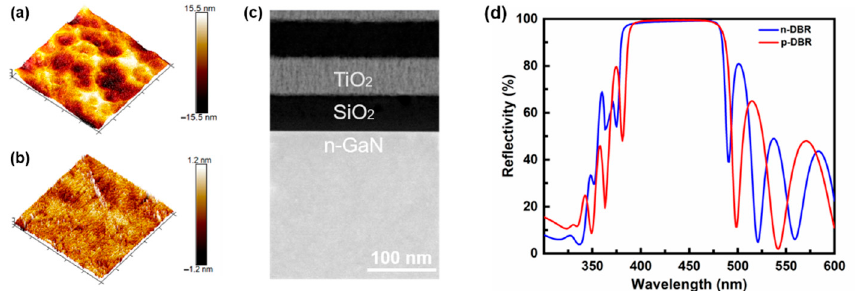
Figure 3. AFM images of the N-face n-GaN surface ( a ) before and ( b ) after the CMP with silica solution showing a scan area of 5 × 5 µ m 2 . ( c ) Cross-sectional STEM image of the interface between the N-face n-GaN and the n-side DBR. ( d ) Experimental reflectance spectra of the n-DBR and p- DBR.